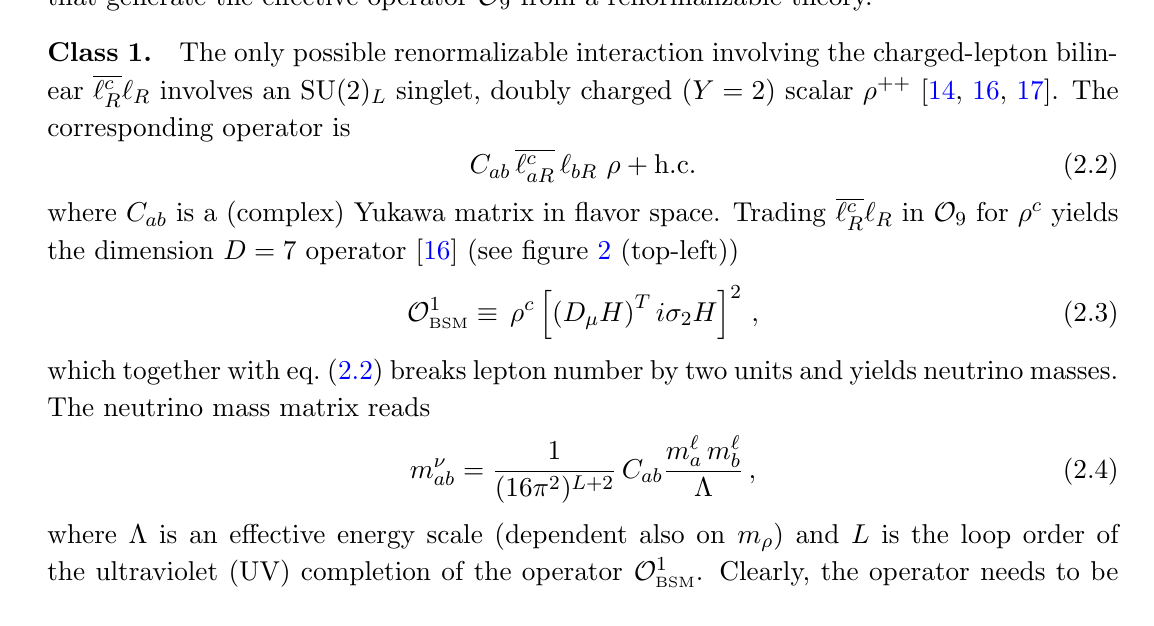
Figure 1 . Left: operator ( ) correspond to SM charged-lepton mass (cid:2)